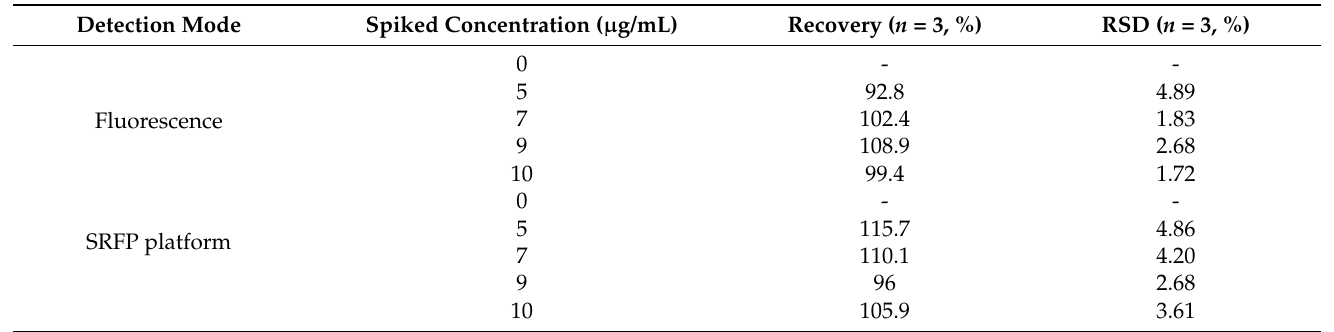
Table 2. Comparison results of bovine serum calcium detection using fluorescence detection method and SRFP